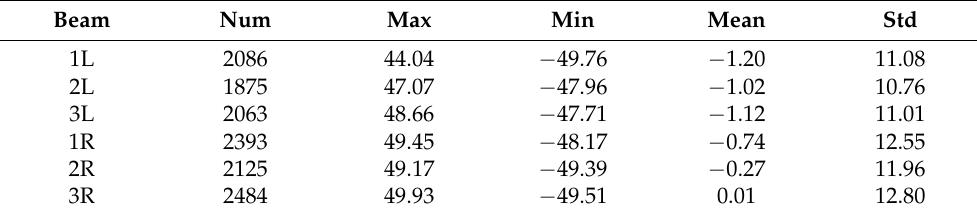
Table 4. Differences in SSHs at the self-crossover points of ICESat-2 within 91 days (Unit: cm). Beam